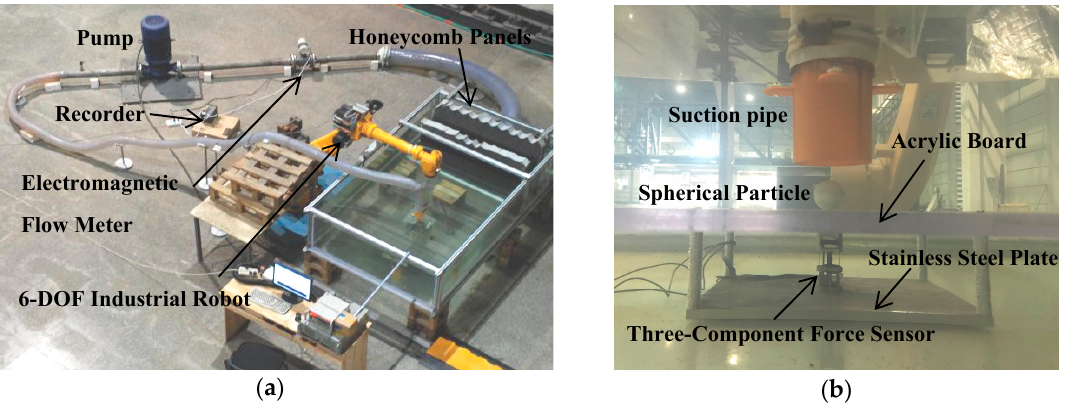
Figure 6. ( a ) Overlook of the test system; ( b ) Front view of the suction part.